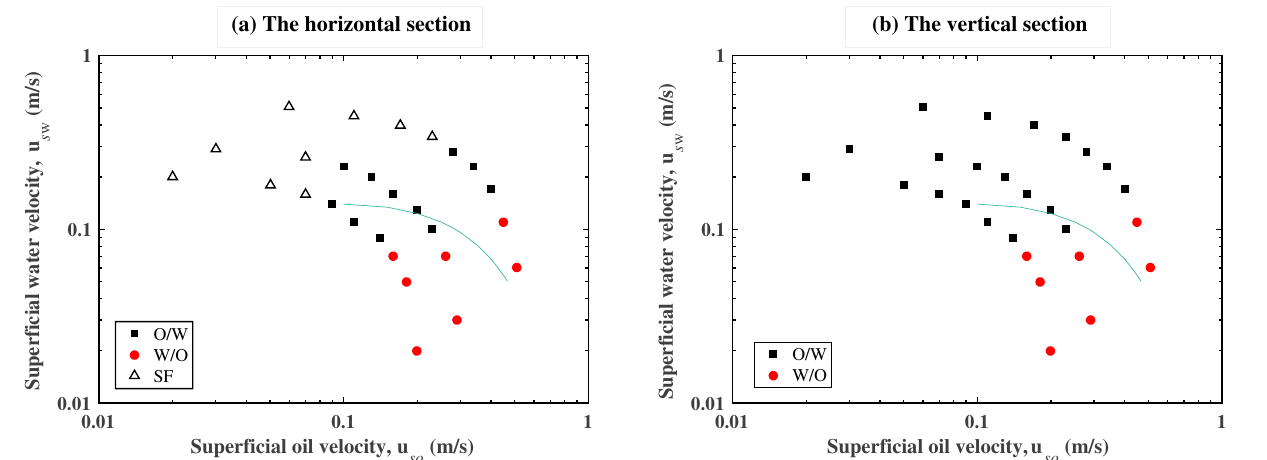
0.1 1 Superficial oil velocity, u (m/s) so Figure 7. Flow pattern maps of oil–water two-phase pipe flow in ( a ) horizontal section and ( b ) vertical section. µ o /µ w = 32 , ρ o /ρ w = 0.84